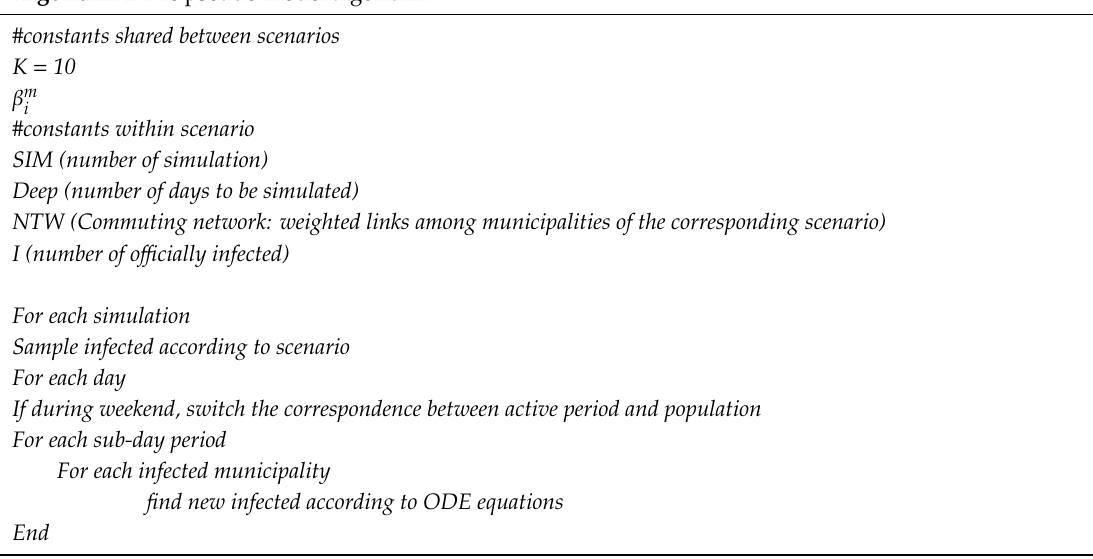
Algorithm 1 The pseudo model